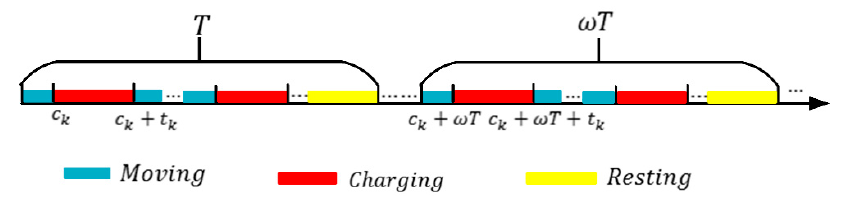
Figure 9. Periodic behavior of the charging car.